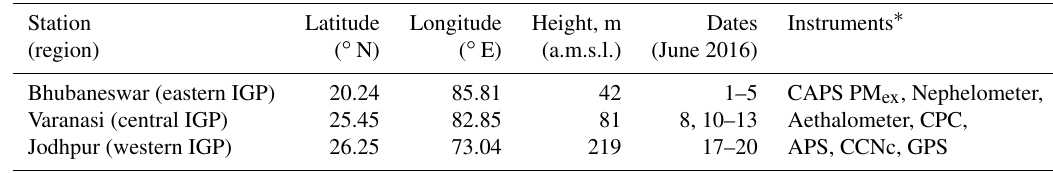
Table 1. Details of the stations and dates on which flight sorties were launched and instruments were operated. Station Latitude Longitude Height, m Dates Instruments ∗ (region) ( ◦ N) ( ◦ E) (a.m.s.l.) (June 2016) Bhubaneswar (eastern IGP) 20.24 85.81 42 1–5 CAPS PM ex , Nephelometer, Varanasi (central IGP) 25.45 82.85 81 8, 10–13 Aethalometer, CPC, Jodhpur (western IGP) 26.25 73.04 219 17–20 APS, CCNc,